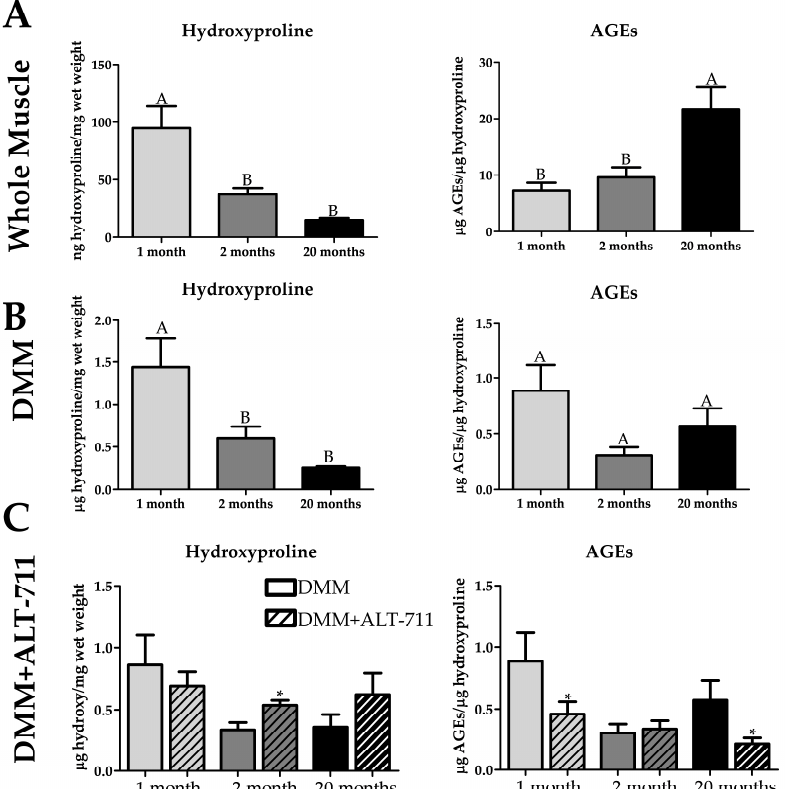
Figure 7. Advanced glycation end products (AGEs) are increased on old age in whole muscle but not in decellularized muscle matrix (DMM). However, the AGE cross ‐ link breaker ALT ‐ 711 reduces the amount of AGEs in aged DMM. ( A ) The amount of detergent and mechanically soluble hydroxyproline is decreased in 2 and 20 months in whole muscle, indicating more cross ‐ linking. AGEs are increased in old whole muscle relative to hydroxyproline (n = 6 in all groups). ( B ) The amount of detergent and mechanically soluble hydroxyproline is decreased in 2 and 20 months in DMM, indicating more cross ‐ linking. However, there is no significant difference in AGEs relative to hydroxyproline with age in DMM (n = 5 for 1 ‐ and 2 ‐ month groups, n = 6 for 20 months). ( C ) After treatment with ALT ‐ 711, the amount of detergent and mechanically soluble hydroxyproline was increased in 2 ‐ month samples compared to untreated age ‐ matched DMM, and there was a reduction in the number of AGEs per hydroxyproline in 1 ‐ month and 20 ‐ month DMM treated with ALT ‐ 711 compared to untreated age ‐ matched DMM, indicating that AGE reduction was effective at all ages. Groups that do not share a letter (e.g. A or B) are statistically different according to a one ‐ way ANOVA followed by a two ‐ tailed Tukey’s correction ( p < 0.05). * = statistically different to the age ‐ matched control group (DMM without ALT ‐ 711) according to a two ‐ tailed unpaired t ‐ test ( p < 0.05, n value detailed in each section).